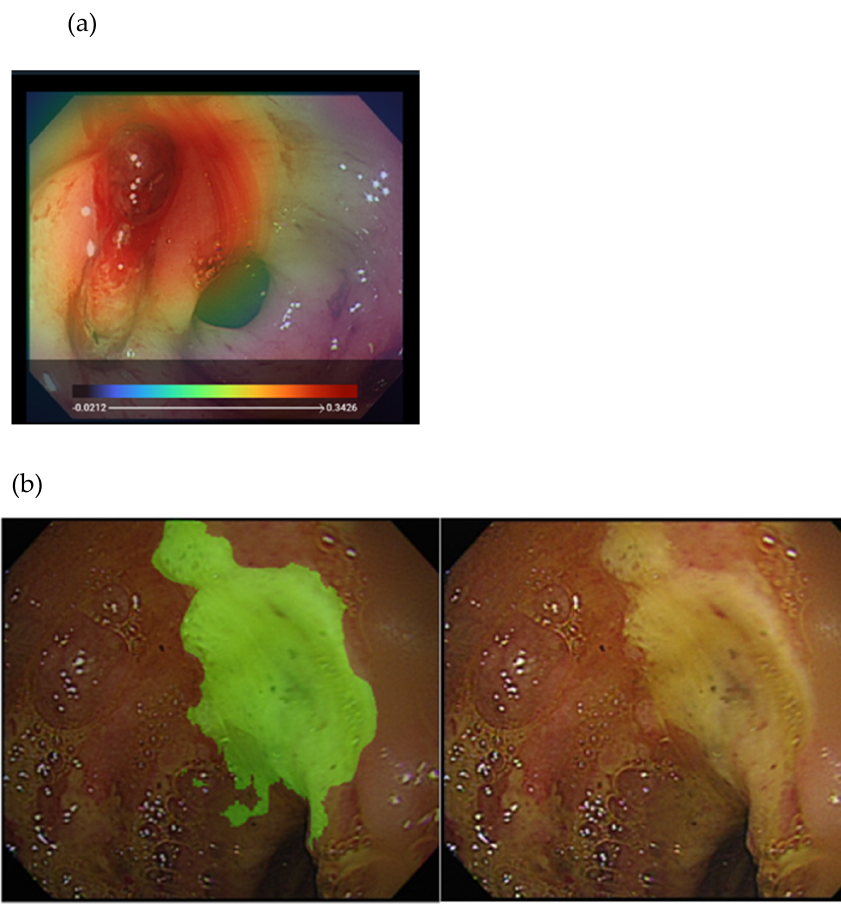
Figure 3. Illustration of the DL approach for analyzing endoscopy images in peptic ulcer disease: ( a ) heatmap image showing an active bleeder in the endoscopy image ( upper ); ( b ) segmentation of the ulcer area ( left ) from the original endoscopy image ( right